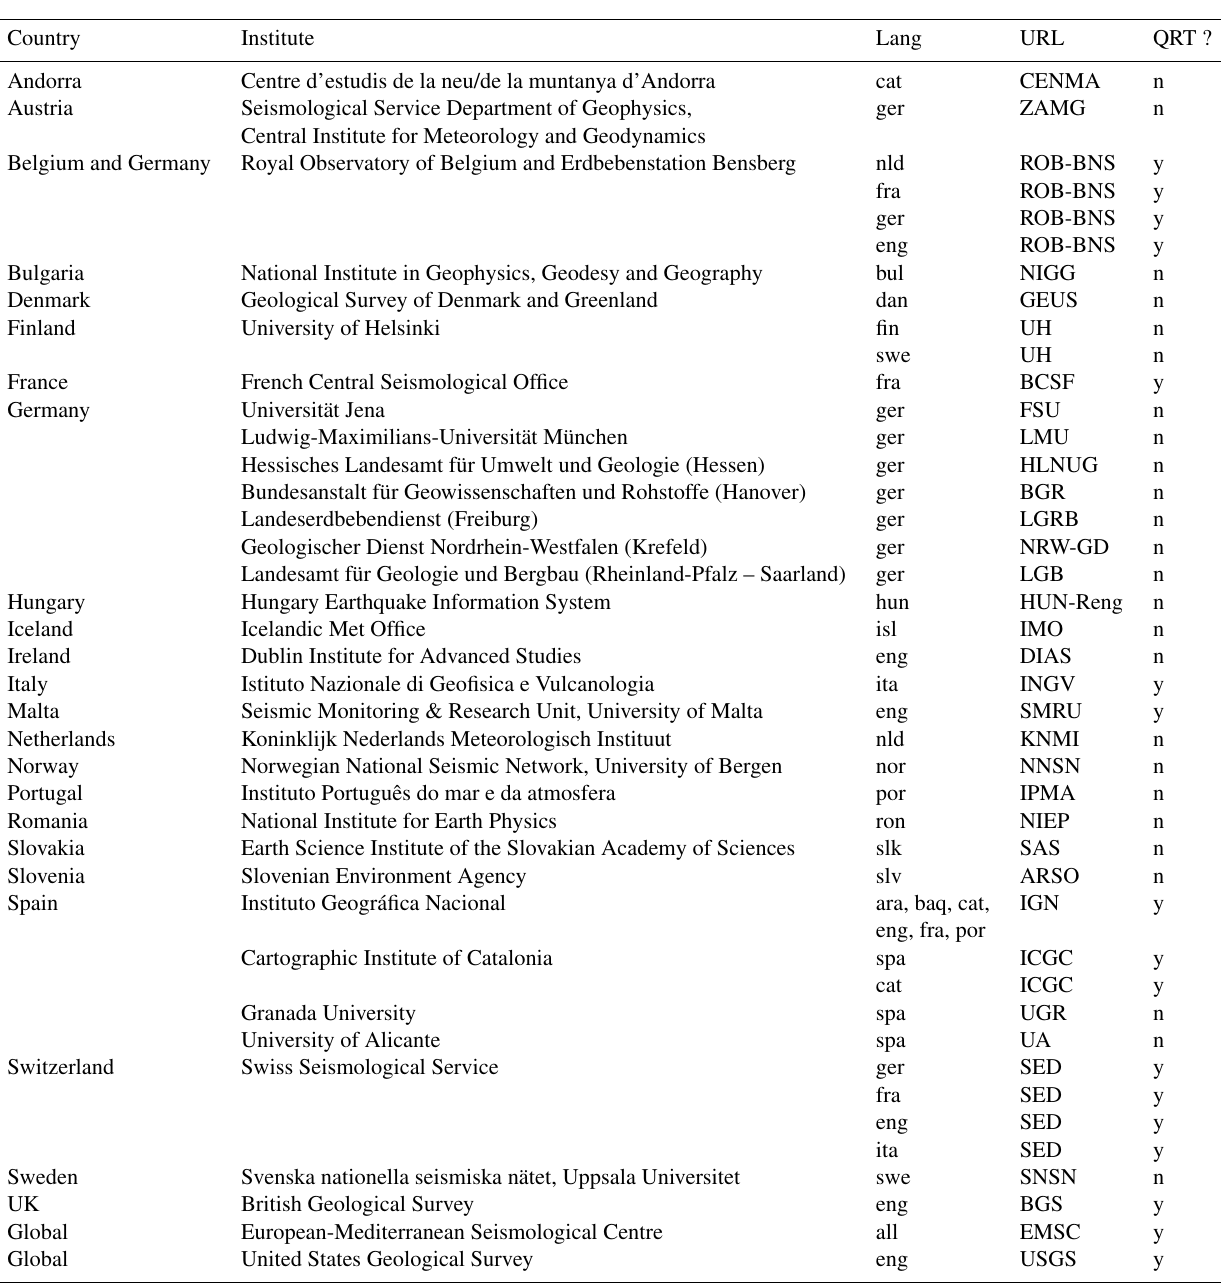
Table A1. Overview of European seismological institutes that provide an online macroseismic inquiry to request responses regarding earth- quakes that have been felt. Hyperlinks to the online questionnaires are provided in the URL column. QRT? (quasi real time?) asks whether the gathered data are mapped and illustrated online in QRT: y(es), n(o). Institutional abbreviations are used in the text. See Appendix B for language abbreviations (all: multilingual